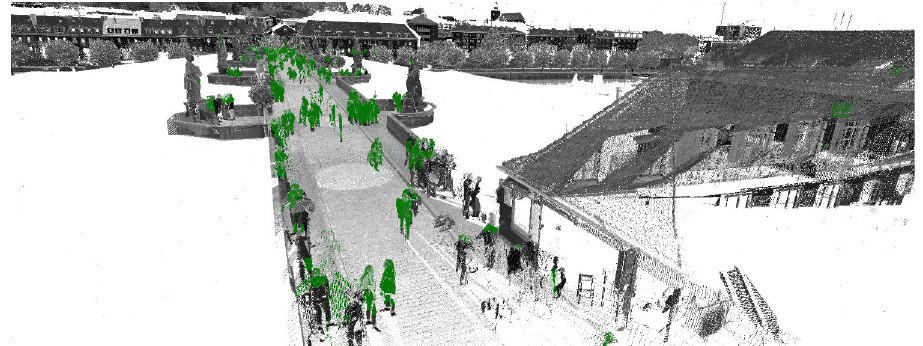
Figure 8. Ground truth of ”The Bridge’. The Grey values represent the reflectance of the materials. Green points are dynamic objects, detected and removed with the peopleremover (Schauer and N¨uchter,